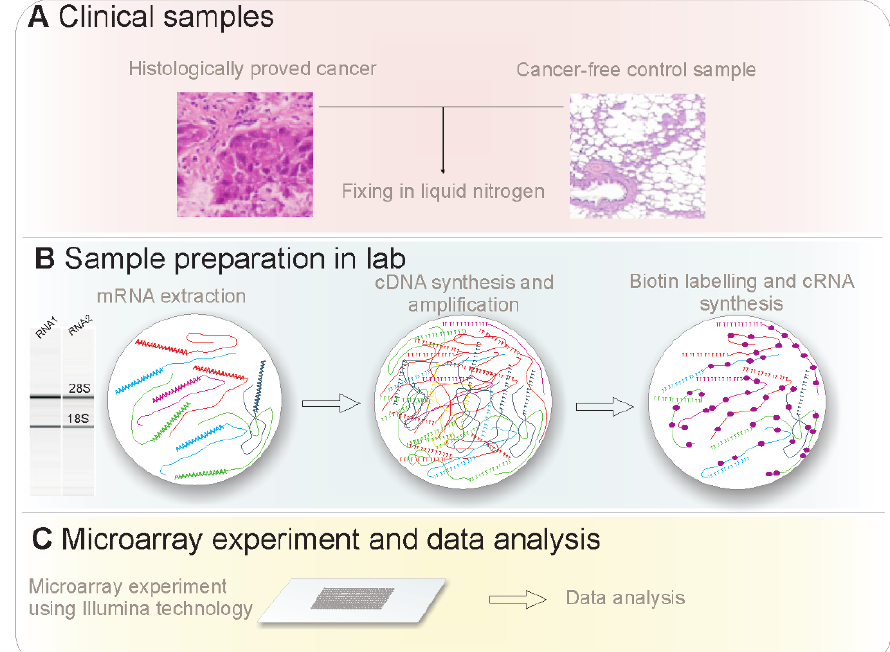
Figure 1. Gene expression profile